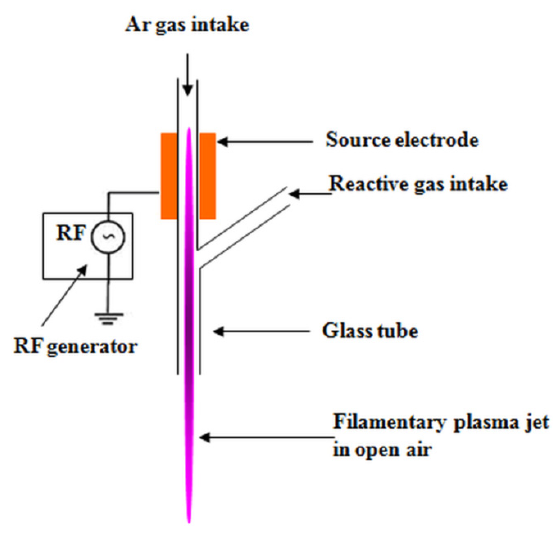
Figure 1. Configuration of the DBD Y-shaped Figure 1. of the DBD Y ‐ shaped source.